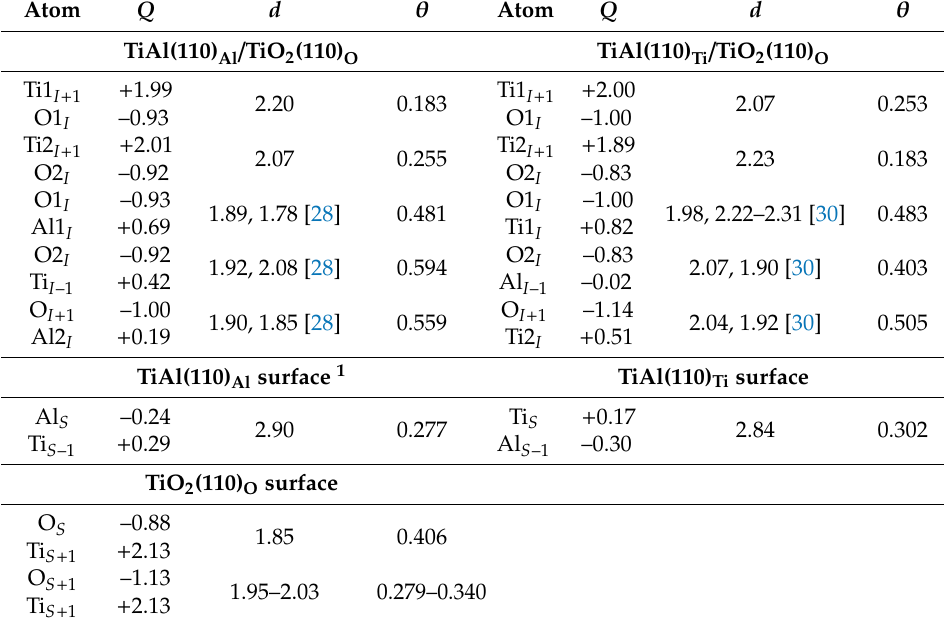
Table 3. Charge states of some interfacial and subinterfacial atoms ( Q in el.), bond length between them ( d in Å) and averaged overlap population ( θ in el.) for pairs of the atoms in the case of the hollow interface configuration. The corresponding data for free surfaces of the alloy and the oxide are given